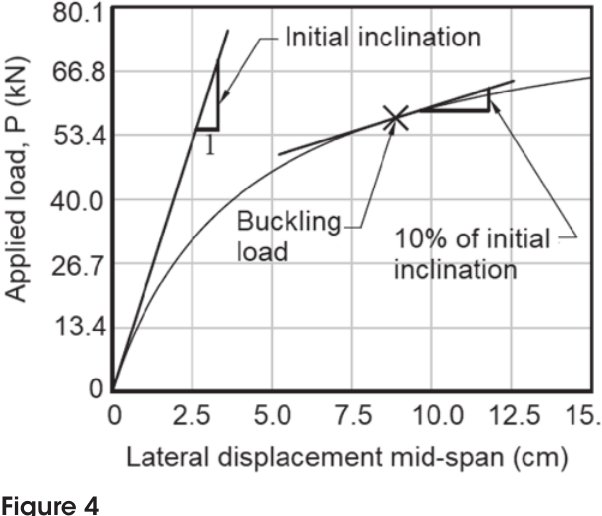
Definition of limit load Source: Adapted from Consolazio, Hamilton and Beery